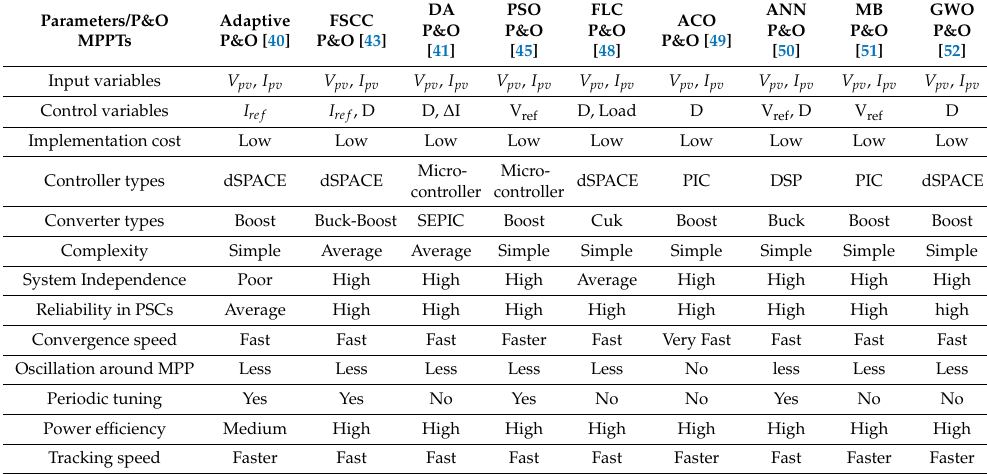
Table 2. Comparison table of P&O